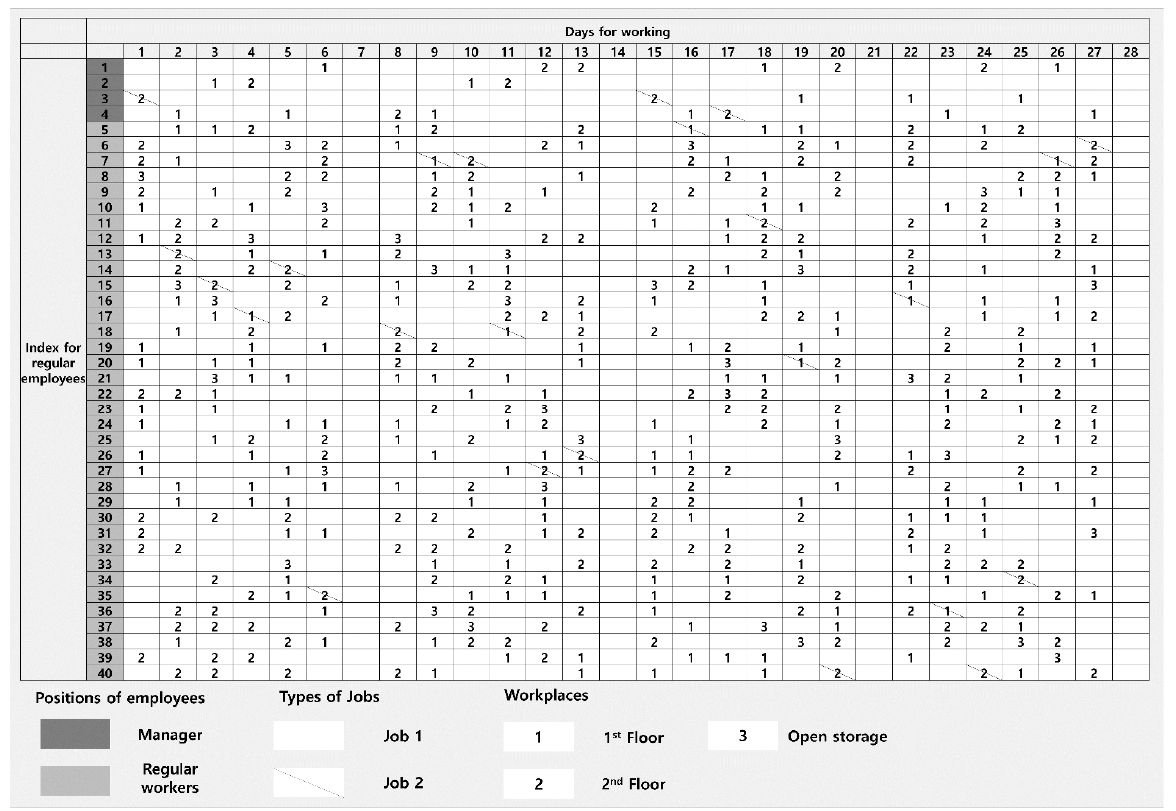
Figure 5. Optimal schedule of regular employees during overtime.